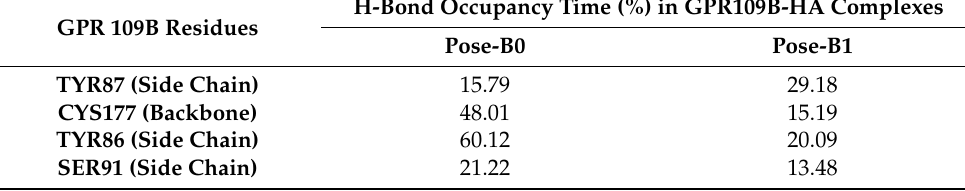
Figure 4. ( A ) Docked structure of GPR109B-HA complex, largest cluster: pose-B0 (purple) and second largest cluster: pose-B1 (yellow). ( B ) Representative structure from the most dominant cluster of GPR109B-HA complex. HA occupies the similar binding site for both the docked poses (pose-B0, purple and pose-B1, yellow) after MD simulation. Table 2. Hydrogen bond (H-bond) occupancy of GPR109B–HA complex. Hydrogen bonds are measured with a cut-off distance of 3.5 Å and occupancy time > 5% are displayed in the table.